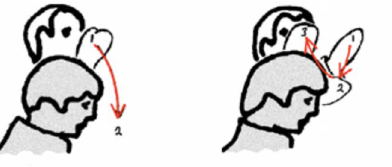
FIG. 3. (cid:1) Color (cid:2) “ (cid:1) I (cid:2) t (cid:3) G-F (cid:4) punctures the thing; it (cid:3) G-S (cid:4) warps it